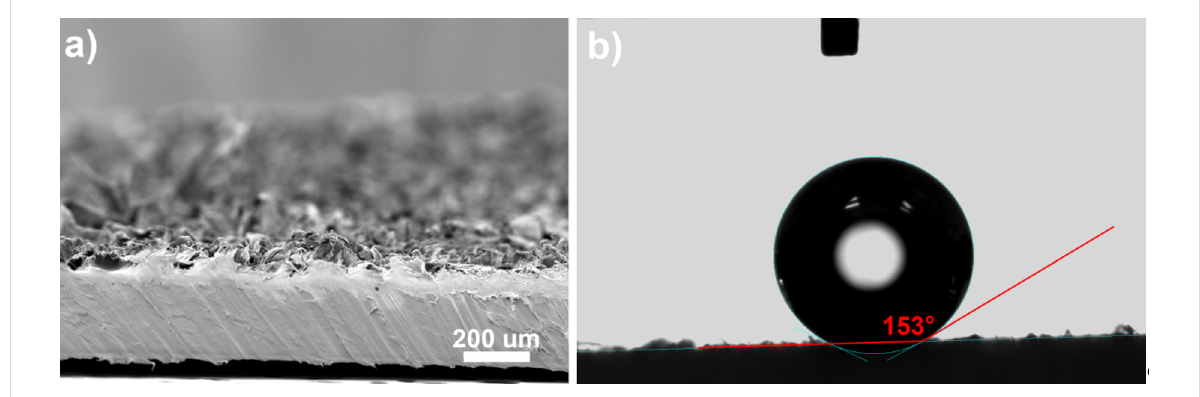
Figure 3: (a) SEM picture of a side cut of a PP nanofur film (view angle 84°). (b) A water droplet of 1 µL on top of the PP nanofur. The contact angle at this spot was 153°.